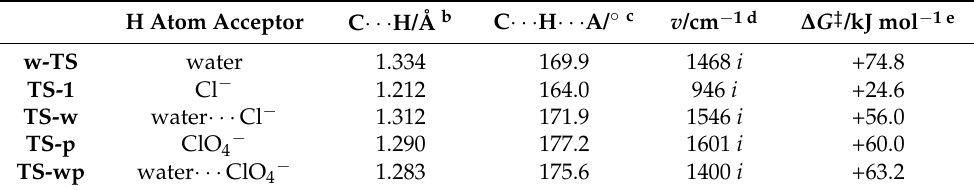
Table 3. Properties of transition state structures in reaction step 2 → 3 obtained from ab initio calcu- lations a in cases for proton transfer from nitrosocarbinolic cation C-H moiety to: water ( w-TS ), a chloride ion within the corresponding CIP ( TS-1 ), water near a chloride ion within the corresponding SSIP ( TS-w ), a perchlorate ion within the corresponding CIP ( TS-p ), and water near a perchlorate ion within the corresponding SSIP ( TS-wp